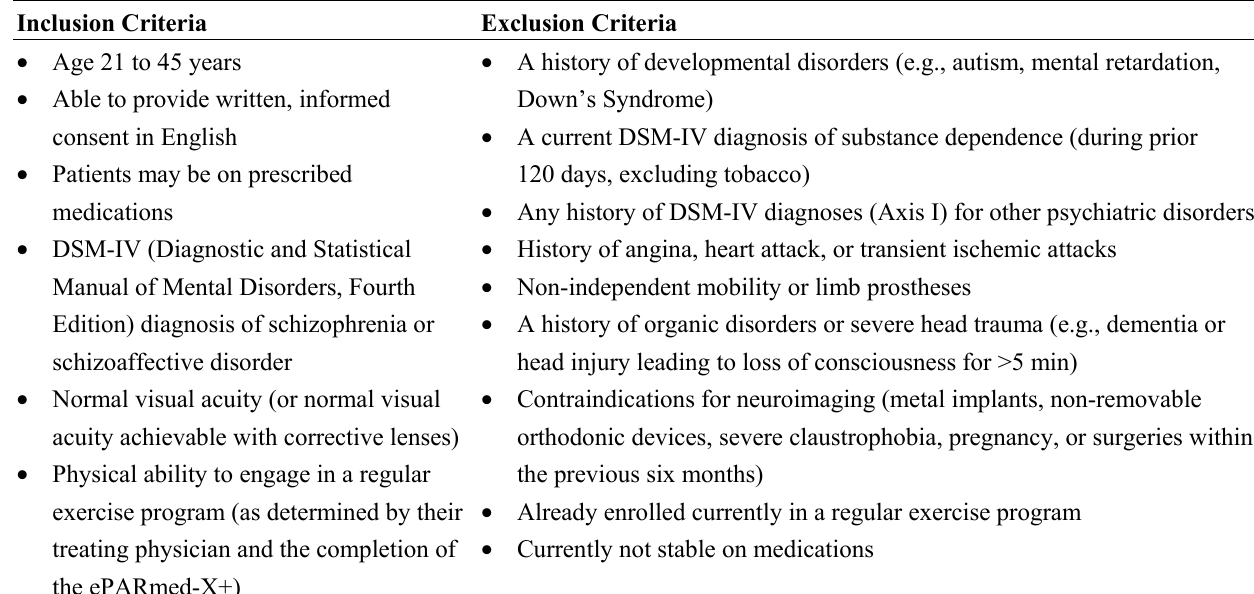
Table 1. Inclusion and exclusion criteria for participants living with